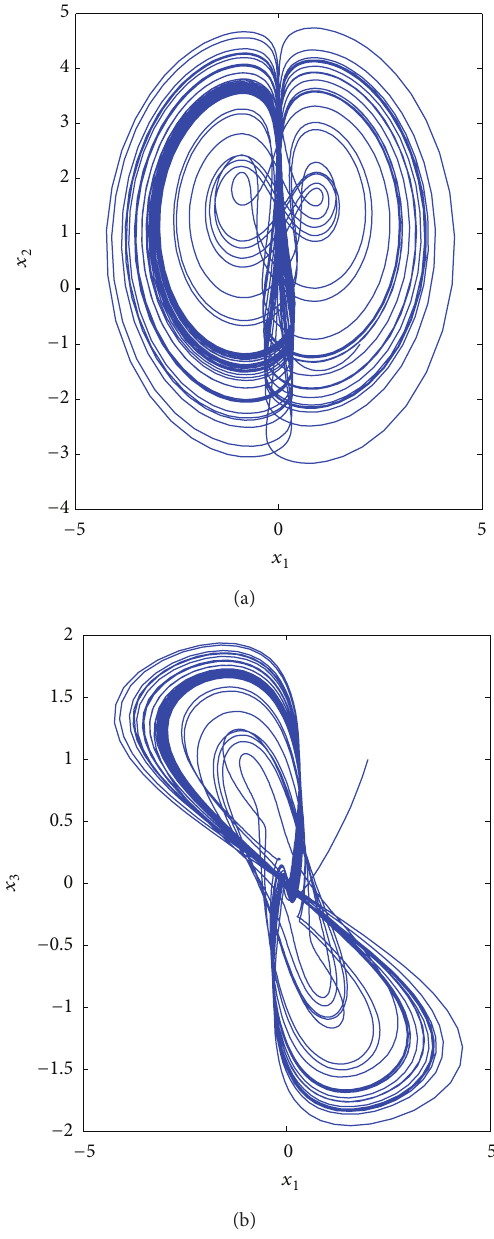
Figure 5: Chaotic attractor of fractional-order financial system with fractional order 𝛼 = 1.04 : (a) 𝑥 1 - 𝑥 2 plane; (b) 𝑥 1 - 𝑥 3